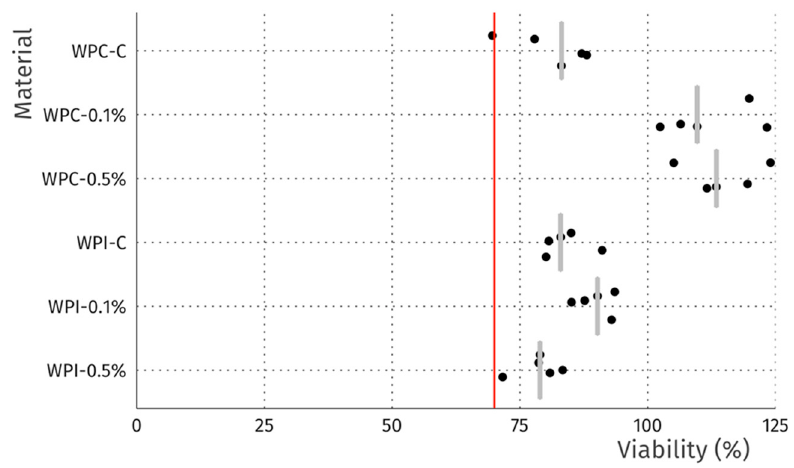
Figure 7. Viability of L929 fibroblasts after 24 h incubation in direct contact with discs. Data is normalized to wells without discs. Dots represent individual discs, grey bars represent median, and the red line indicates 70% viability, the threshold for cytotoxicity.